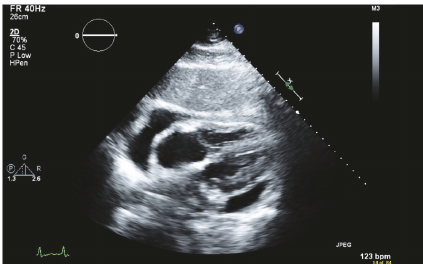
Figure 2:Subcostal viewof the pericardial effusion on transthoracic